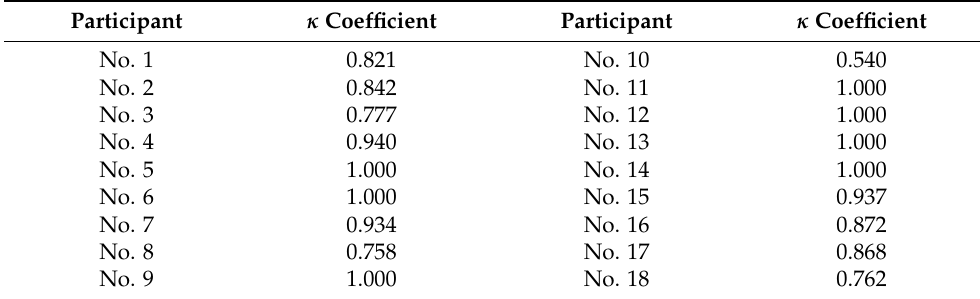
Table 1. The results of test re-test reliability of the instrument of the “Oral Side Effects of COVID-19 Vaccine” study (OSECV) 1